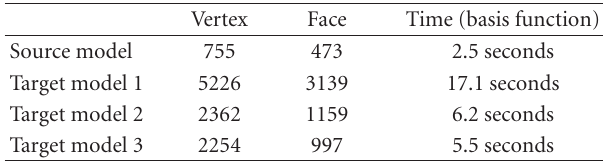
Table 1: Expression cloning. Time took to compute the basis functions for each target